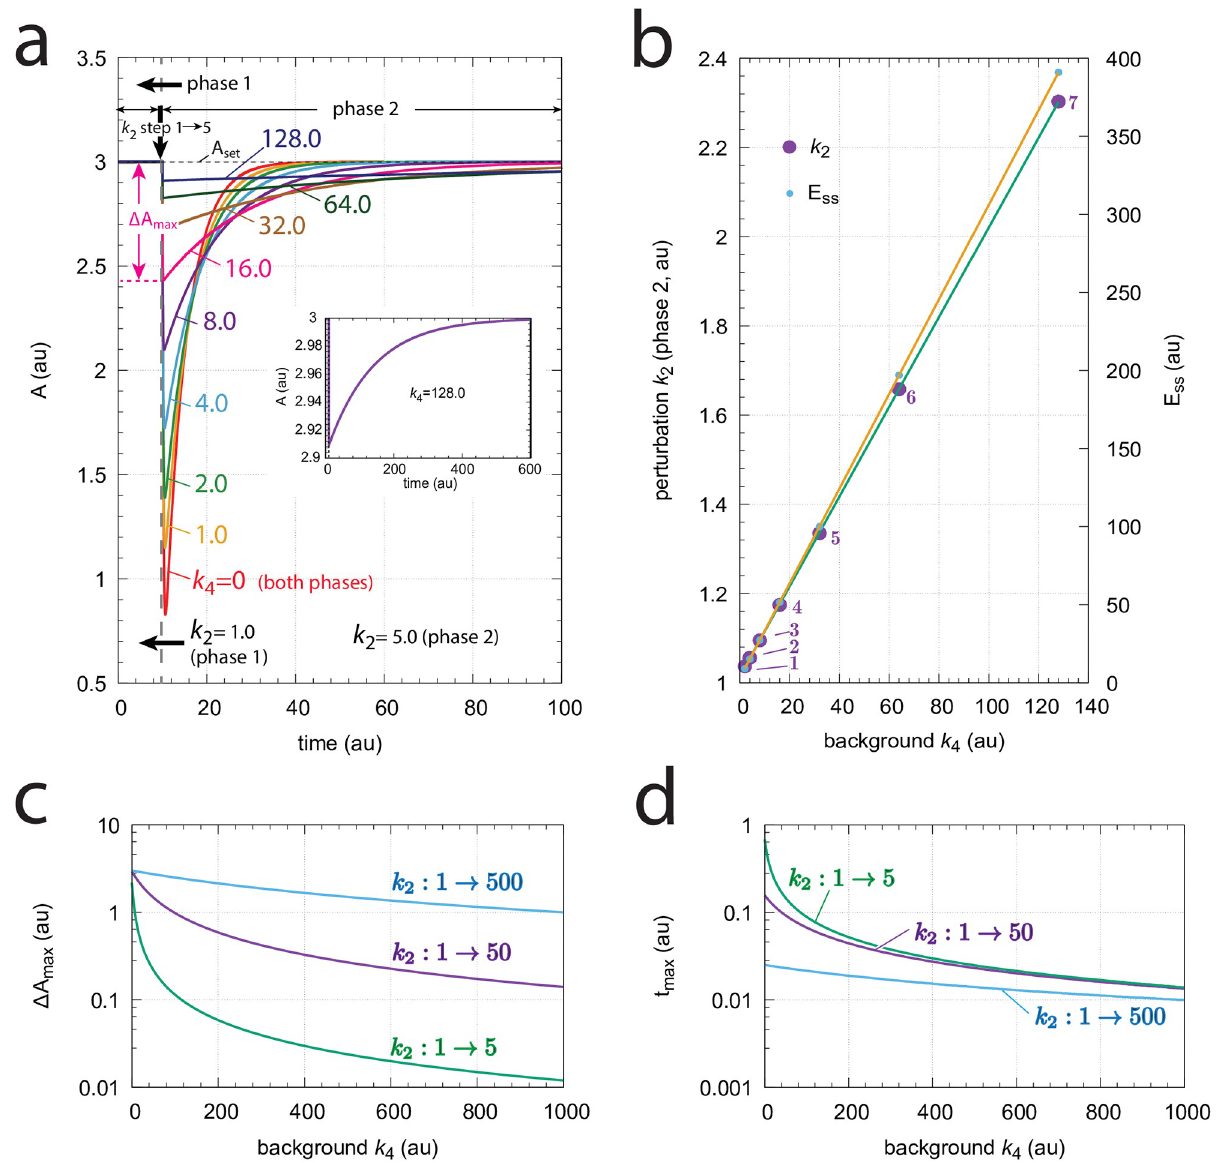
Fig 4. Response kinetics and relationship to Weber’s law in the m1 controller (Fig 3). The set-point of A is 3.0. (a) Step-wise increase of k 2 from 1.0 to 5.0 at time t =10 at different but constant backgrounds k 4 (0–128.0, phases 1 and 2). Note the successive decrease in the maximum excursion of A ( Δ A max ) with slowed-down A resetting kinetics as k 4 backgrounds increase. Δ A max for k 4 =16.0 is indicated. The inset shows that even at high backgrounds the controller is fully operative. Rate constants (in au): k 1 =0.0, k 2 =1.0 (phase 1), k 2 =5.0 (phase 2), k 3 =1.0, k 4 variable, k 5 =3.0, k 6 =1.0, k 7 =1 × 10 − 6 . Initial concentrations (in au): A 0 =3.0, E 0 =3.0 ( k 4 =0); A 0 =3.0, E 0 =6.0 ( k 4 =1); A 0 =3.0, E 0 =9.0 ( k 4 =2); A 0 =3.0, E 0 =15.0 ( k 4 =4); A 0 =3.0, E 0 =27.0 ( k 4 =8); A 0 =3.0, E 0 =51.0 ( k 4 =16); A 0 =3.0, E 0 =99.0 ( k 4 =32); A 0 =3.0, E 0 =195.0 ( k 4 =64); A 0 =3.0, E 0 =387.0 ( k 4 =128). The inset shows the full adaptation response when k 4 =128.0 (b) Relationship to Weber’s law: When perturbation k 2 in phase 2 is adjusted such that the maximum (just noticeable) excursion in A is 0.03 (i.e. 1% of A set ) then both k 2 and the “perception” E ss are linear functions of different but constant backgrounds k 4 . Rate constants and initial concentrations as in (a), except that k 2 in phase 2 has the following values: 1 , k 2 = 1.0367 ( k 4 = 2); 2 , k 2 = 1.0559 ( k 4 = 4); 3 , k 2 = 1.0950 ( k 4 = 8); 4 , k 2 = 1.1745 ( k 4 = 16); 5 , k 2 = 1.3350 ( k 4 = 32); 6 , k 2 = 1.6581 ( k 4 = 64); 7 , k 2 = 2.3030 ( k 4 = 128). (c) Δ A max as a function of background k 4 at three different k 2 steps. (d) t max as a function of background k 4 at three different k 2 steps. Rate constants are as in panel (a), except for k 2 and k 4 . Initial concentrations are the steady state values of A and E prior to the step in k 2 .